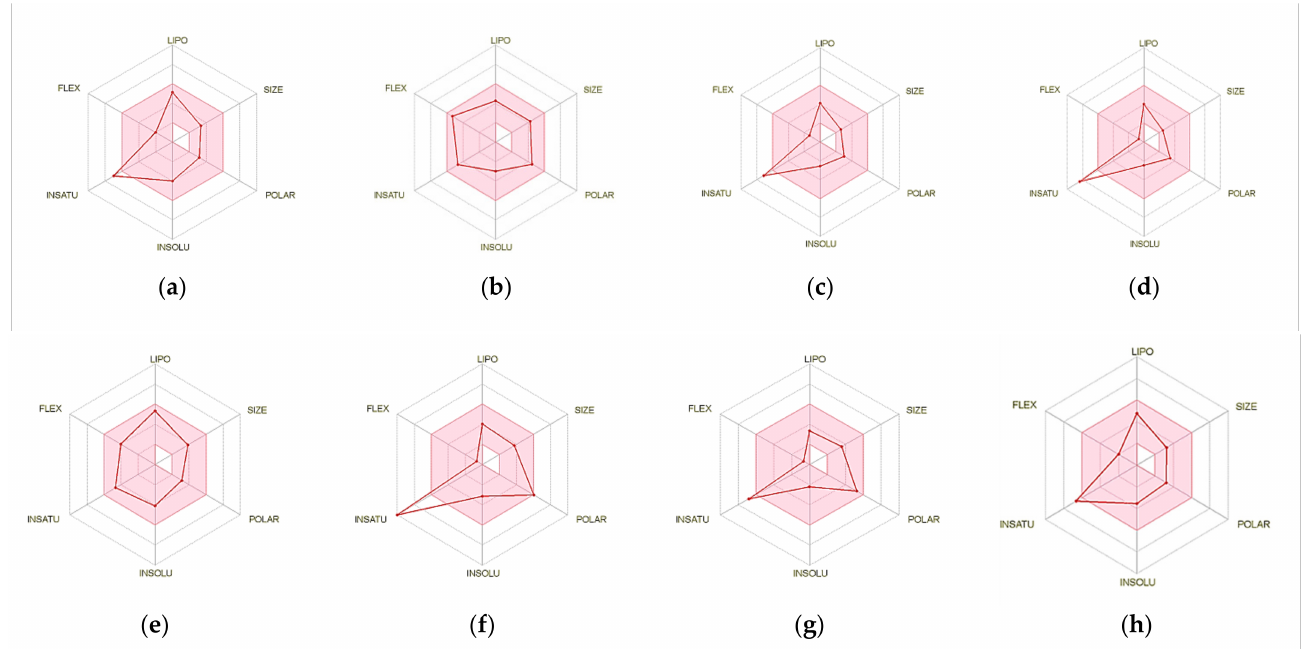
Figure 3. Bioavailability radar (pink area exhibits optimal range of particular property) for studied compounds (LIPO = lipophilicity as XLOGP3; SIZE = size as molecular weight; POLAR = polarity as TPSA (topological polar surface area); INSOLU = insolubility in water by log S scale; INSATU = instauration as per fraction of carbons in the sp3 hybridization and FLEX = flexibility as per rotatable bonds). ( a ) = Marmelide, ( b ) = Marmenol, ( c ) = Scoparone, ( d ) = Scopoletin, ( e ) = 6 (cid:48) , 7 (cid:48) –epoxyauraptene, ( f ) = Quercetin, ( g ) = Catechin, ( h ) =